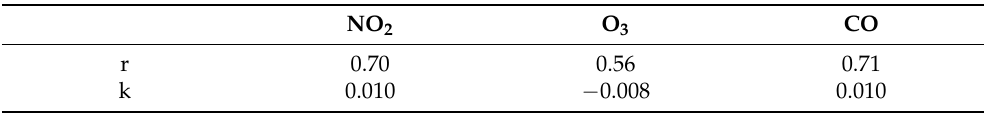
Figure 3. The distribution of the UMPI over the study area. Colors represent the values of the UMPI, and the grayscale represents building height. Table 5. Correlation between the UMPI and the standardized pollution concentration (i.e., NO 2 , O 3 , CO) at the ground level.